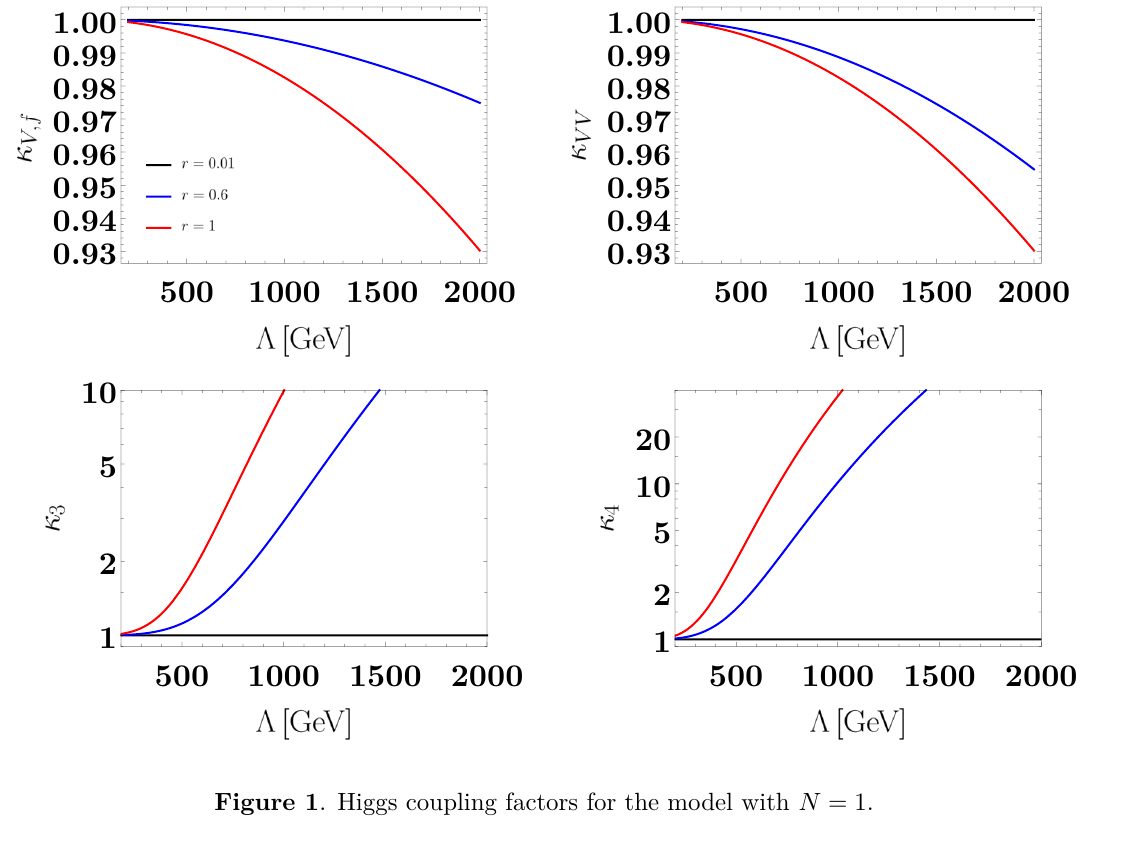
Figure 1 . Higgs coupling factors for the model with N = 1